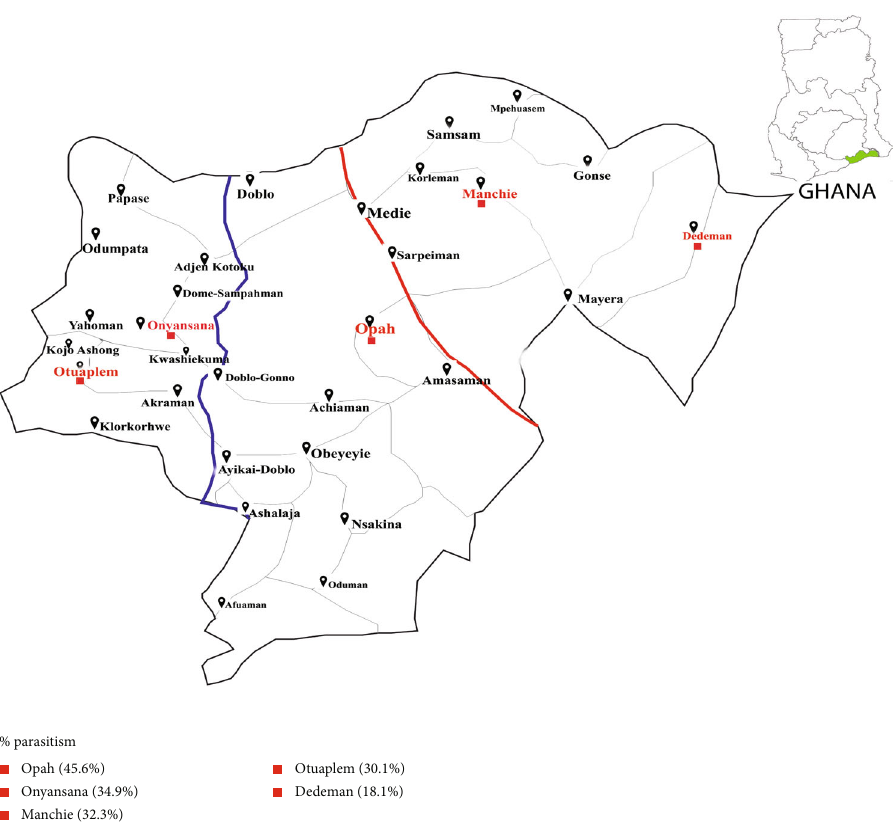
Figure 1: Map of Ga West Municipality, Ghana, showing study sites in red and prevalence of parasitism in study communities (the map is the authors ’ own